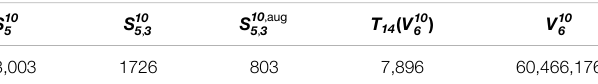
TABLE 3 | Degrees of freedom for the full space S d g , the TT variant S d g , ρ maximal block size ρ max (cid:1) 3, the space T r ( V d p ) with TT rank bounded by r (cid:1) 14, and the full space V d p for